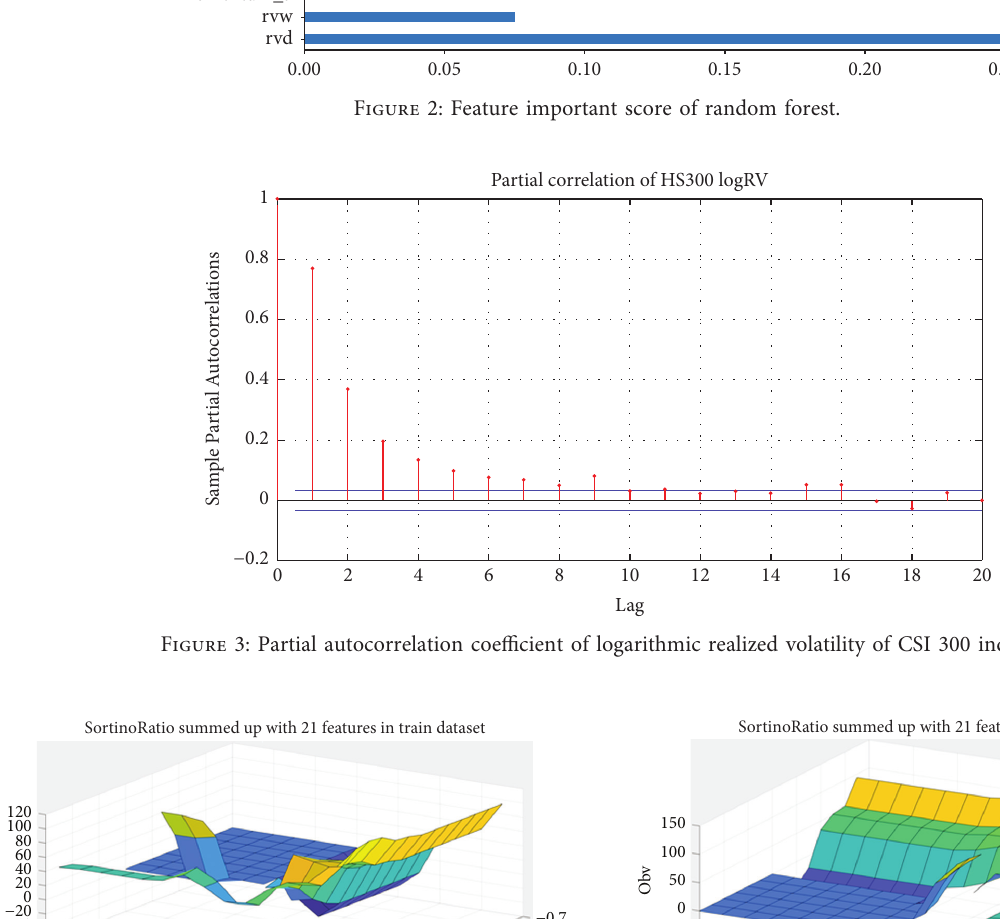
−60 0.7 0.6 0.5 0.4 0.3 0.2 Figure 4: Visualization of results of grid optimization algorithm 1. Figure 5: Visualization of results of grid optimization algorithm